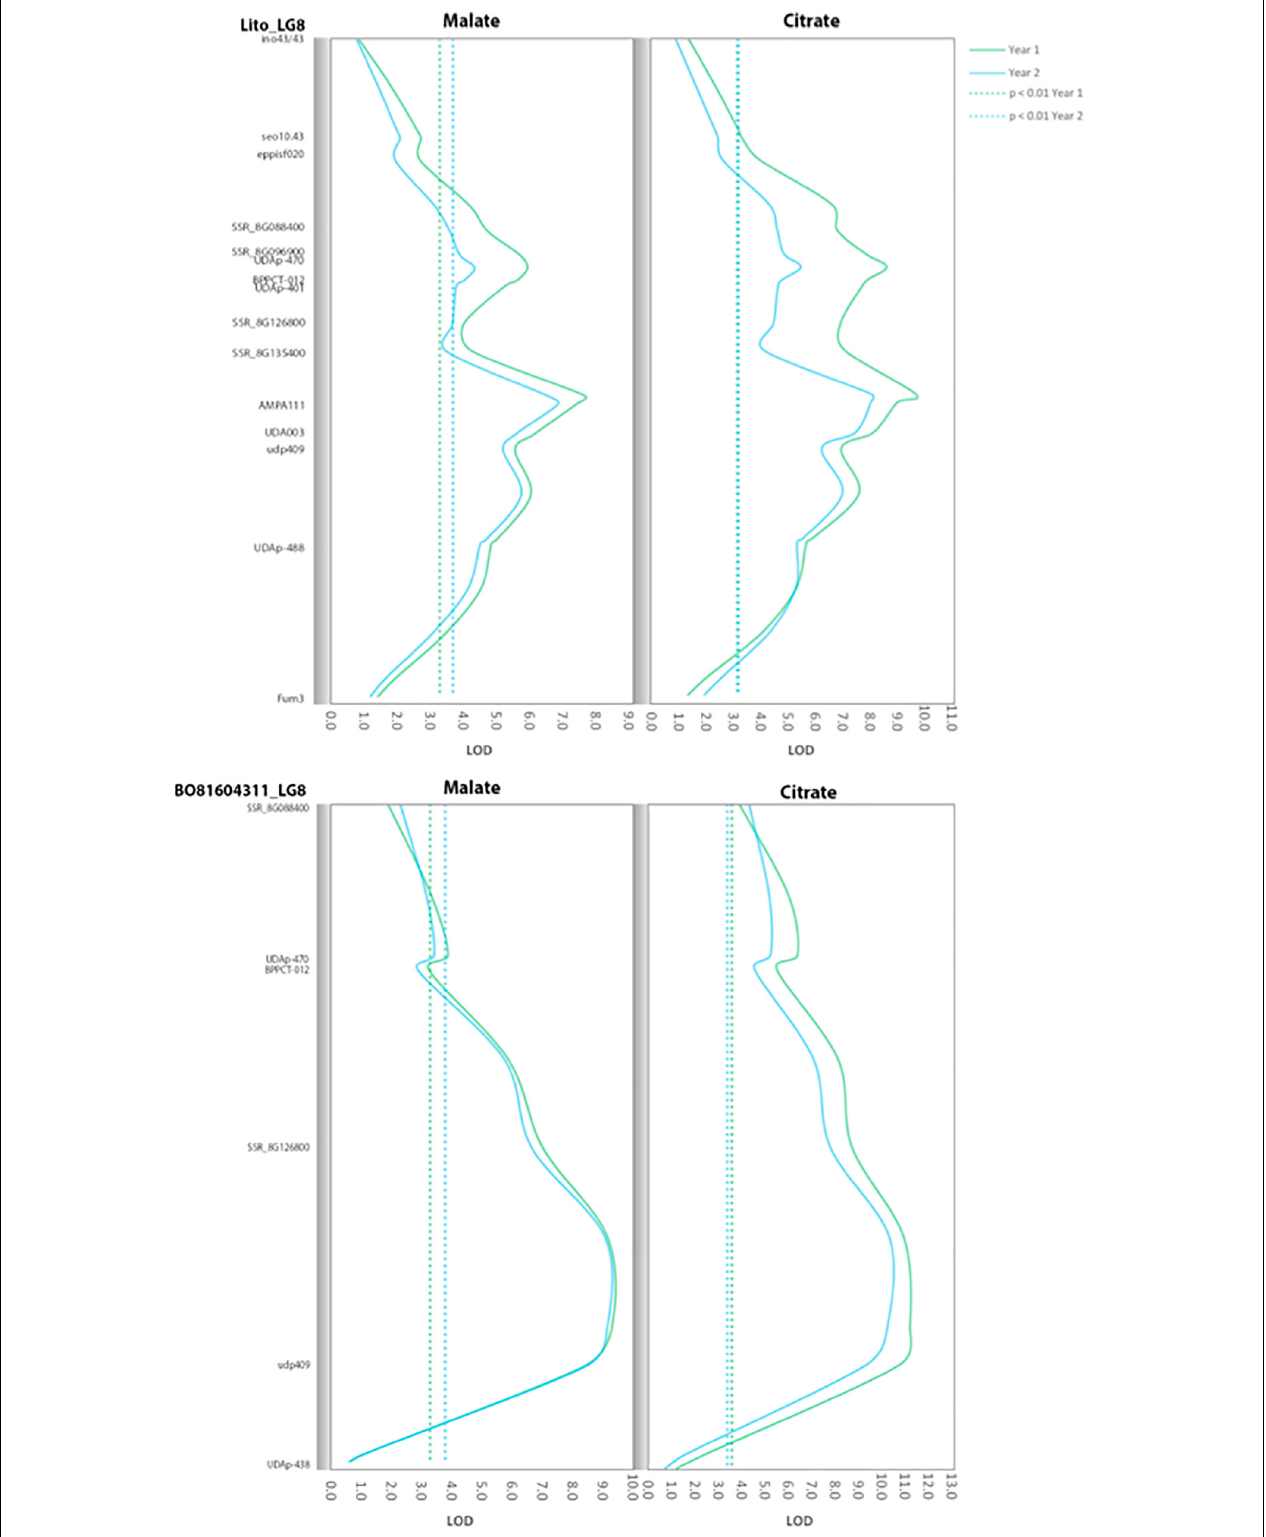
FIGURE 2 | Positions of the quantitative trait loci (QTLs) for citrate and malate contents found in LG8 of ‘Lito’ and ‘BO81604311.’ The dotted line represents the significance threshold of the QTL.